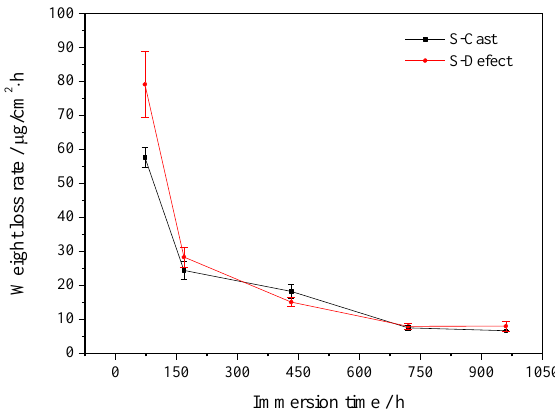
Figure3. WeightlossrateofS-CastandS-Defectimmersedfordi ff Figure 3. Weight loss rate of S-Cast and S-Defect immersed for different time periods in artificial seawater.